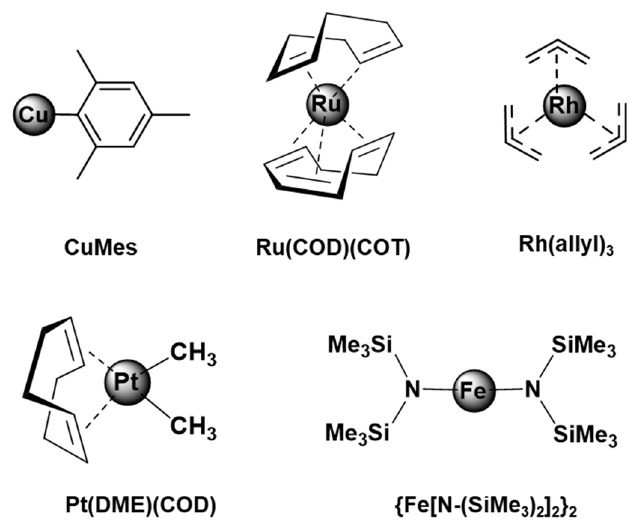
Figure 3. Example of organometallic precursors used in the organometallic approach for the preparation of MNPs. CuMes (Mes = mesitylene); Ru(COD)(COT) (COD = cyclooctadiene; COT = cyclooctatriene); Pt(DME)(COD) (DME = dimethyl); Rh(allyl) 3 (allyl = η 3 -C 3 H 5 ); {Fe[N-(SiMe 3 ) 2 ] 2 } 2 .